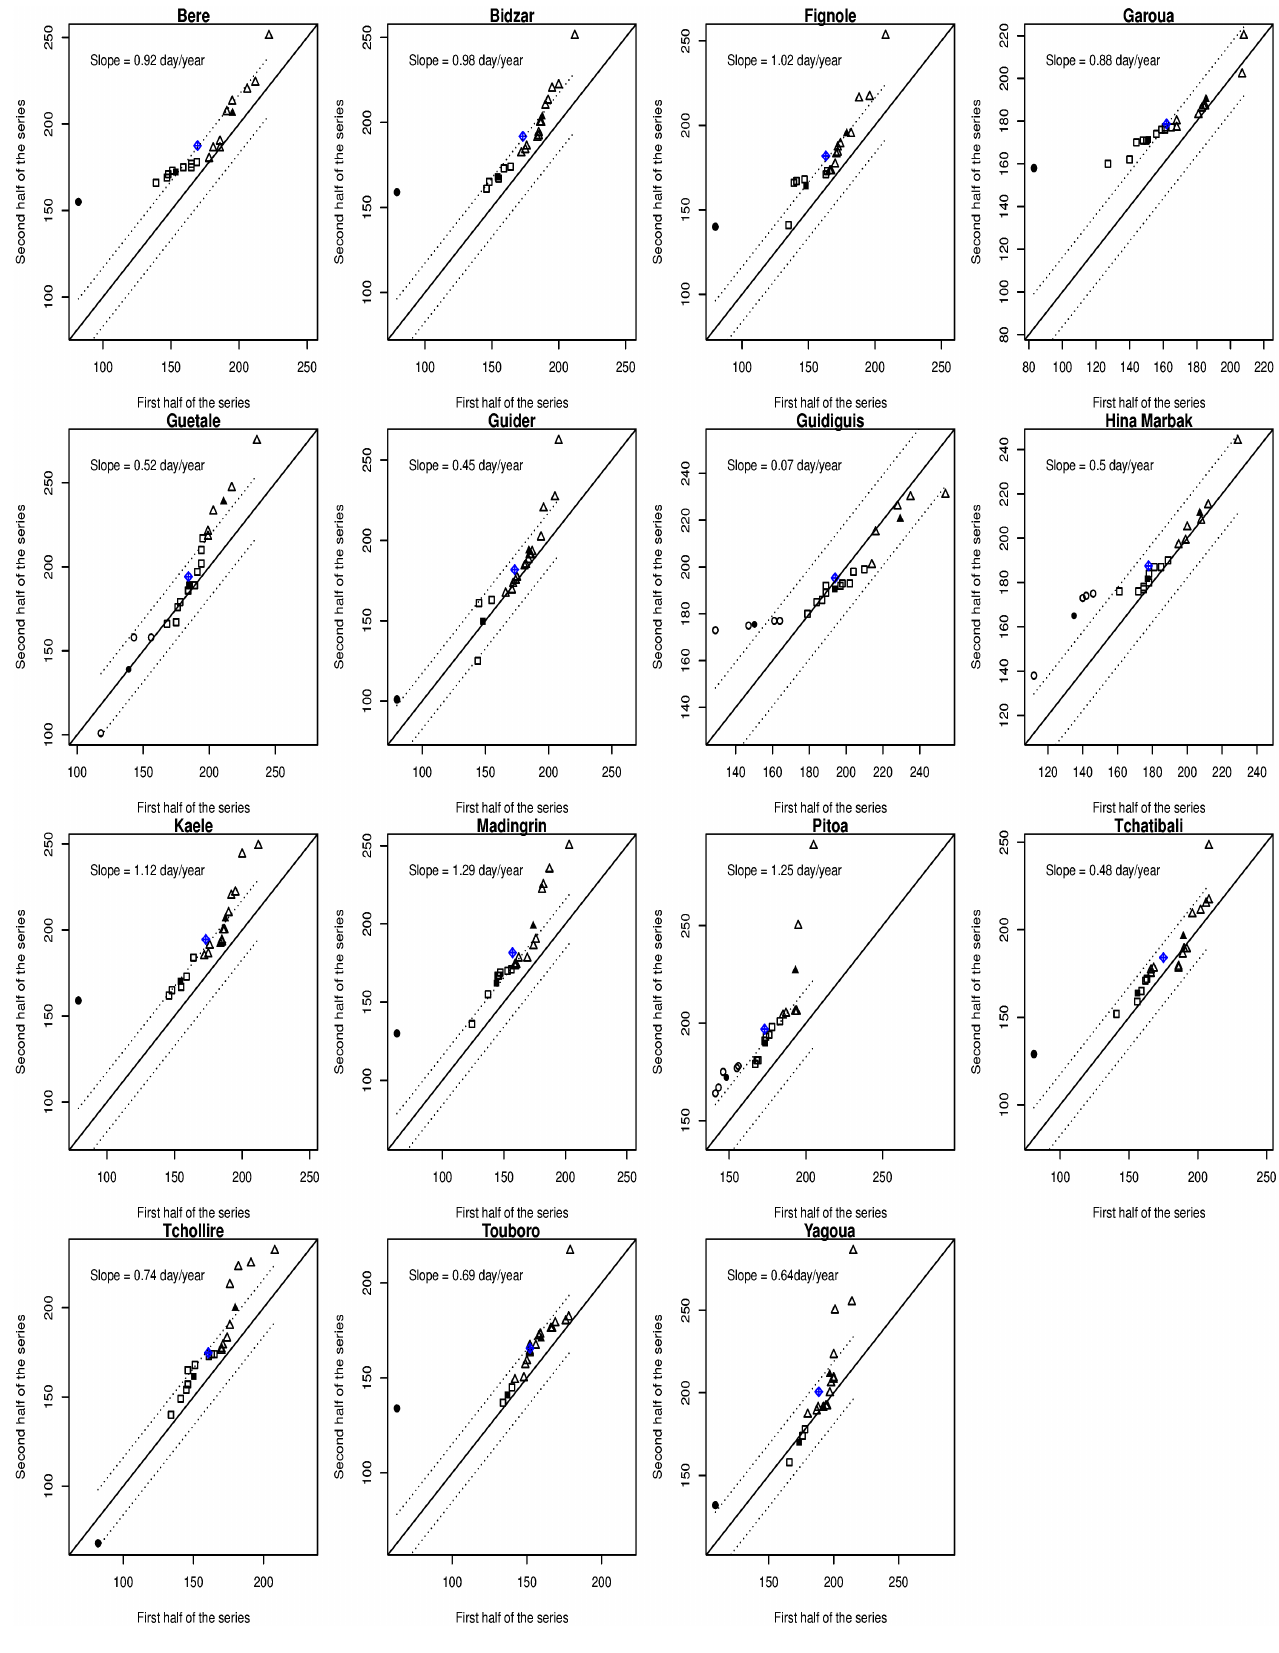
Figure 12. As in Figure 11, but for CDD.